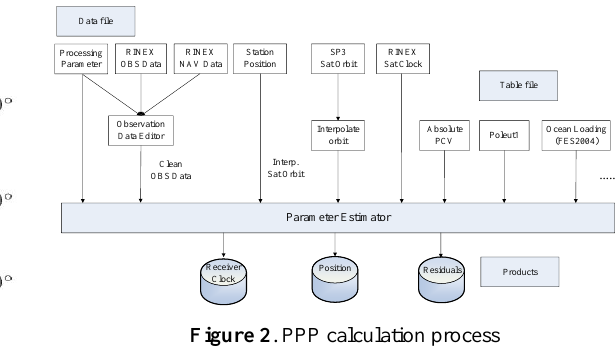
Figure 2 . PPP calculation